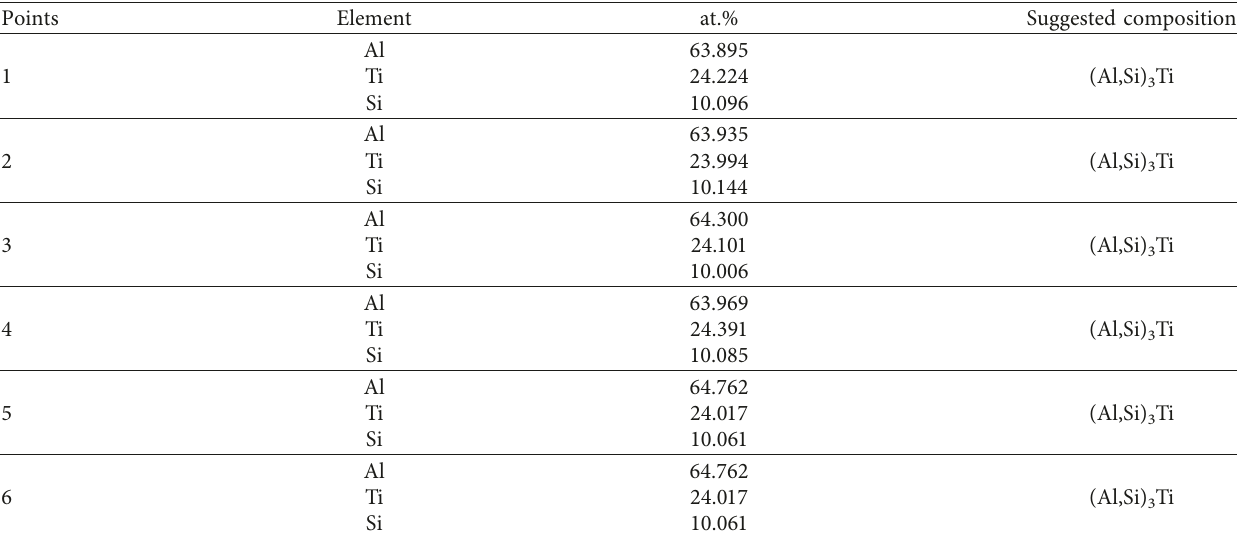
Figure 5: Element distribution in the (Al,Si) Table 2: Identification of the phase rich in